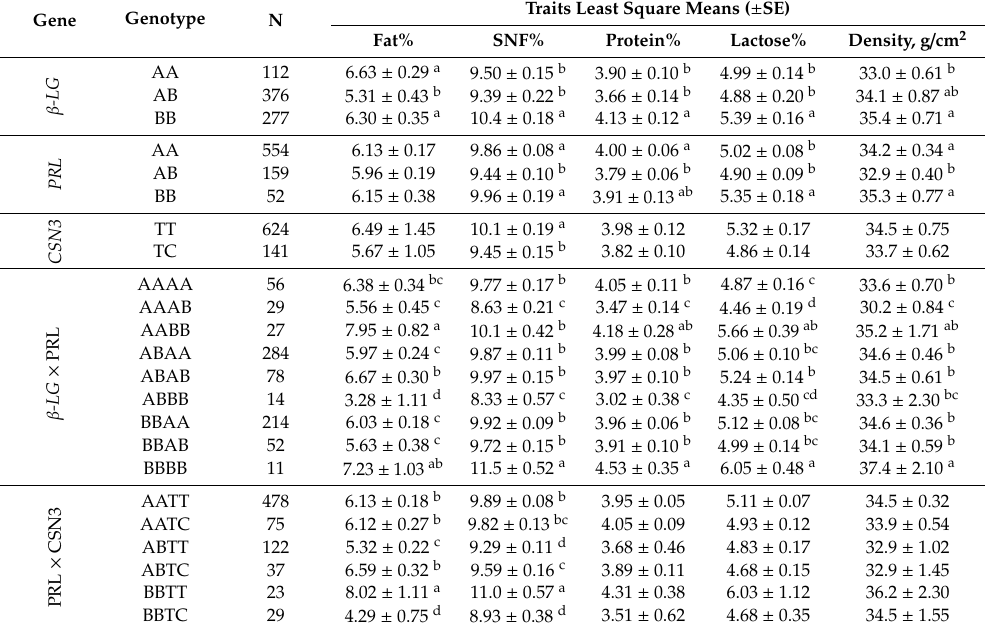
Table 6. E ff ect of β -LG , PRL , and CSN3 genotypes and their interacting e ff ects on milk composition traits in Awassi